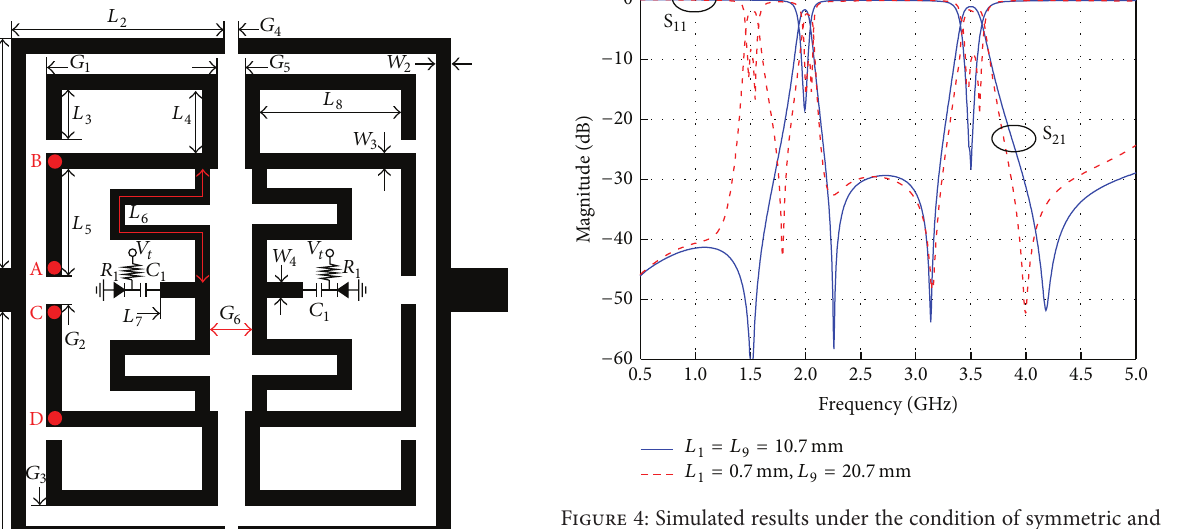
Figure 4: Simulated results under the condition of symmetric and asymmetric port position.